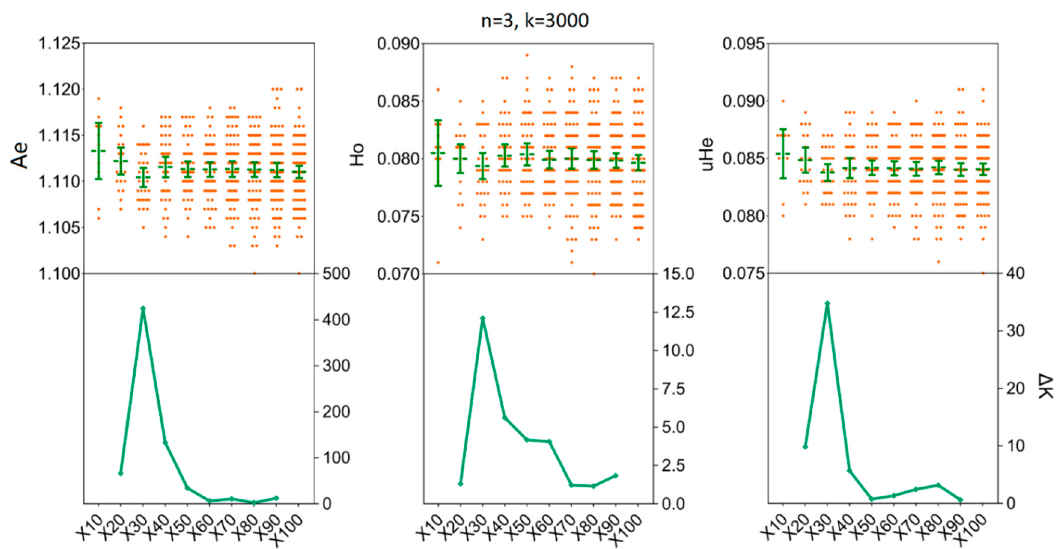
Figure 4. The minimum number of resampling replicates (x) required to estimate the genetic diversity in PLKK population. Bars represent sample means and 95% confidence intervals of the means. The Δ K ( Y -axis) shows a clear peak at the optimal replicates (x). Ae , number of effective alleles; Ho, observed heterozygosity; uHe , unbiased expected heterozygosity.